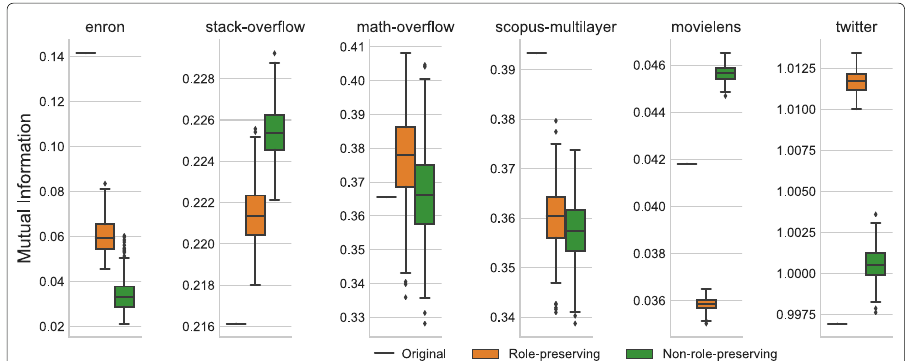
Fig. 5 The average local role mutual information across data sets, with comparisons to the role-preserving (green) and non-role-preserving ensembles (green). In all cases, the observed value falls outside the inter-quartile range for the role-preserving ensemble (orange), and in all but the math-overflow data set for the non-role-preserving ensemble